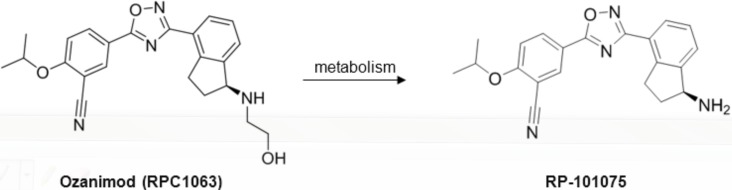
Chemical structure of ozanimod (RPC1063) and RP-101075.